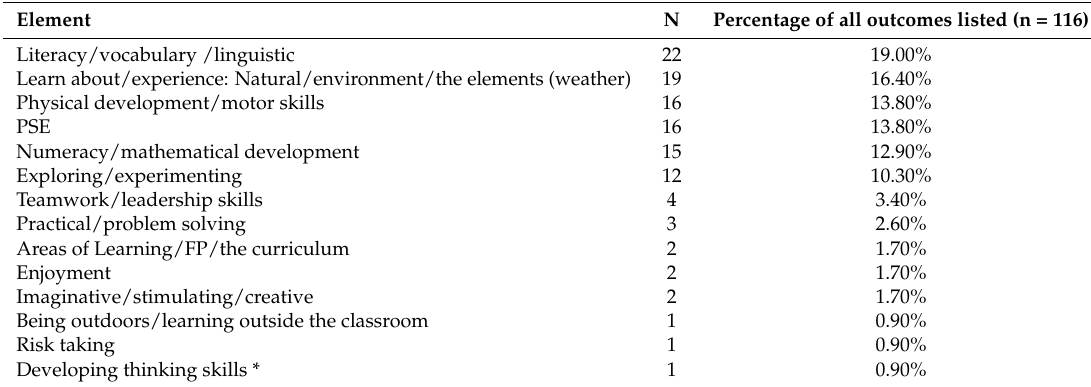
Table 4. Welsh sample: Elements arising from analysis of ‘learning outcomes’ question and associated % of coded